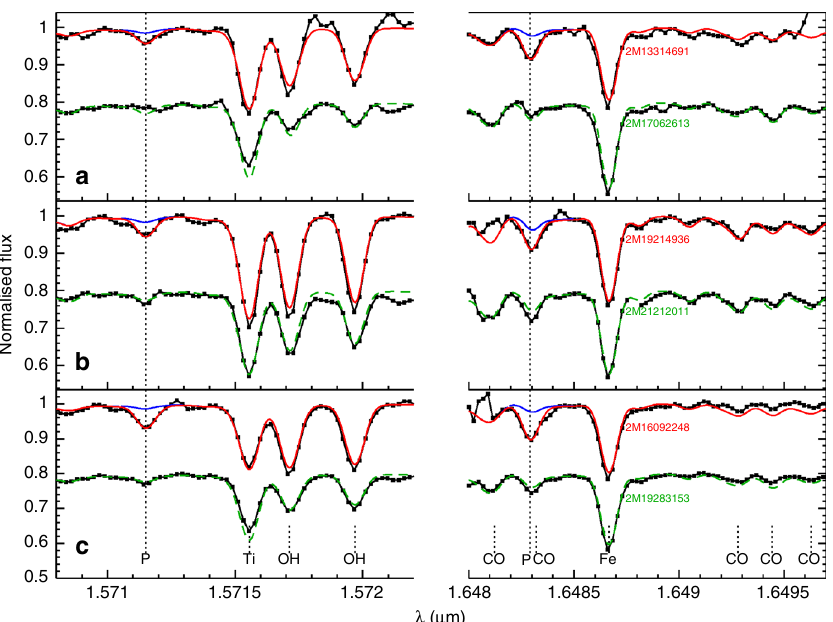
Fig. 2 Sample spectra of P-rich stars. Observed H-band spectra (in black) of three P-rich stars and P-normal stars ( a – c ) around the two P I absorption lines at 15711.5 and 16482.9 Å. A gap in between wavelengths has been introduced to highlight the wavelength discontinuity. The best model spectra (respectively in red for the P-rich stars and green for the P-normal stars) are shown together with model spectra without the P lines (in blue). The P-normal stars spectra have been offset by − 0.2 in fl ux for display purposes.